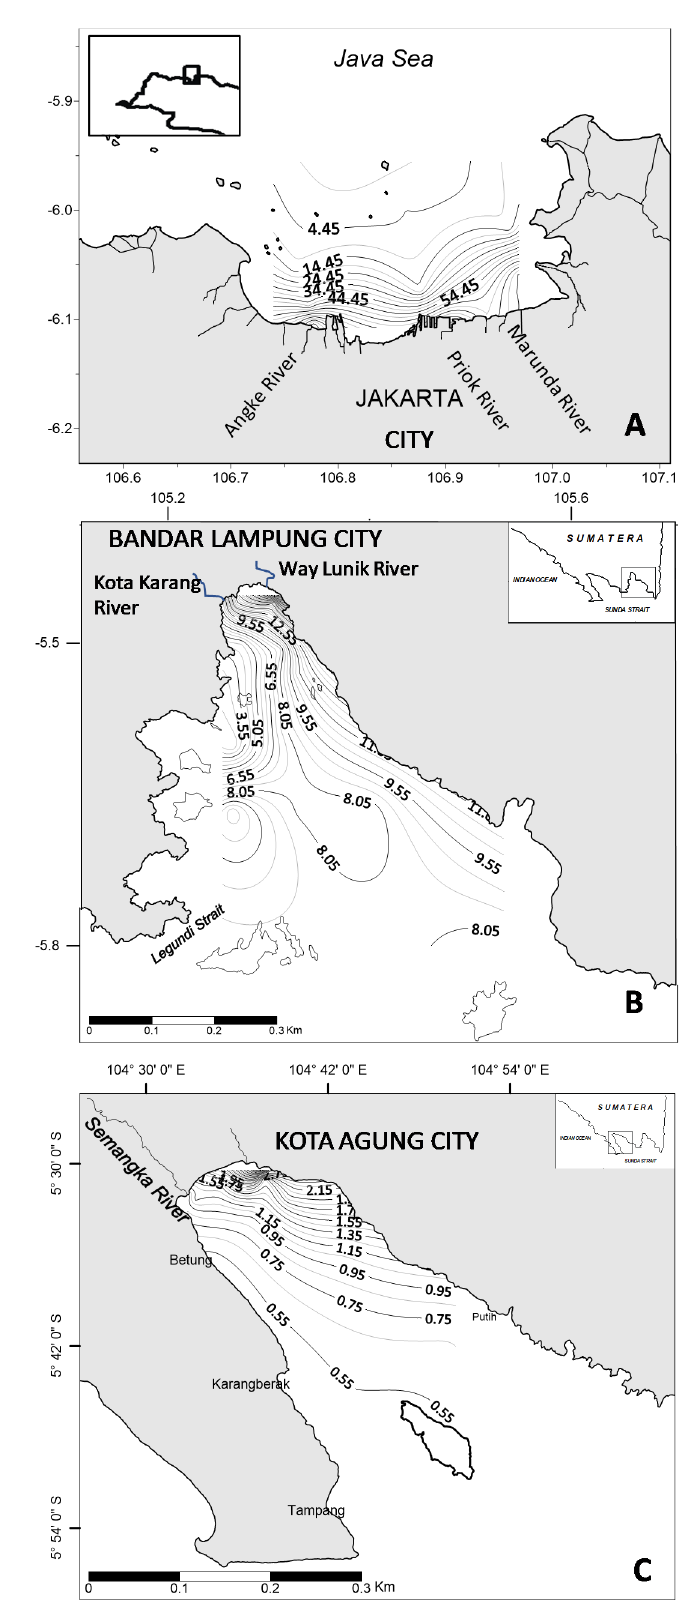
Figure 3. Spatial distribution of the annual mean concentration values ( μ g L − 1 ) of total phytoplankton pigments (including Chl-a) in Jakarta Bay (upper graph ( A )), Lampung Bay (middle graph ( B )), and Semangka Bay (lower graph ( C )).